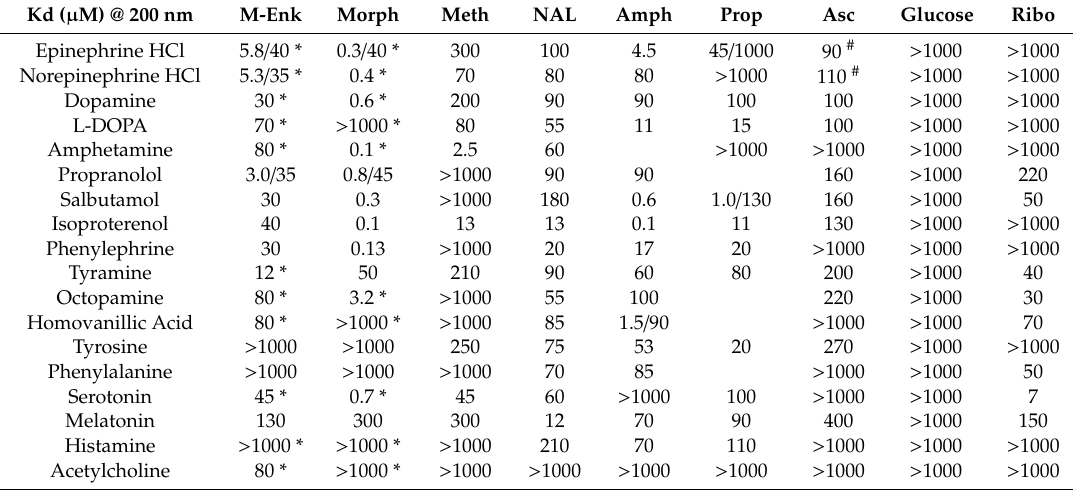
Table 1. Results of ultraviolet spectroscopy study of binding between opioids, neurotransmitters, sugars, and vitamins. Binding constants are given in micromoles. Where two numbers are present, the experiment yielded a double curve, so that two binding constants were calculated: one represents high a ffi nity binding, and the other, low a ffi nity binding. M-Enk = methionine-enkephalin; Morph = morphine sulfate; Meth = methadone; NAL = naloxone; Amph = amphetamine; Prop = propranolol; Asc = ascorbic acid (vitamin C); Ribo = Riboflavin; l -DOPA = l -3,4-dihydroxyphenylalanine. * = binding confirmed by NMR spectroscopy [78]. # = binding confirmed by capillary electrophoresis